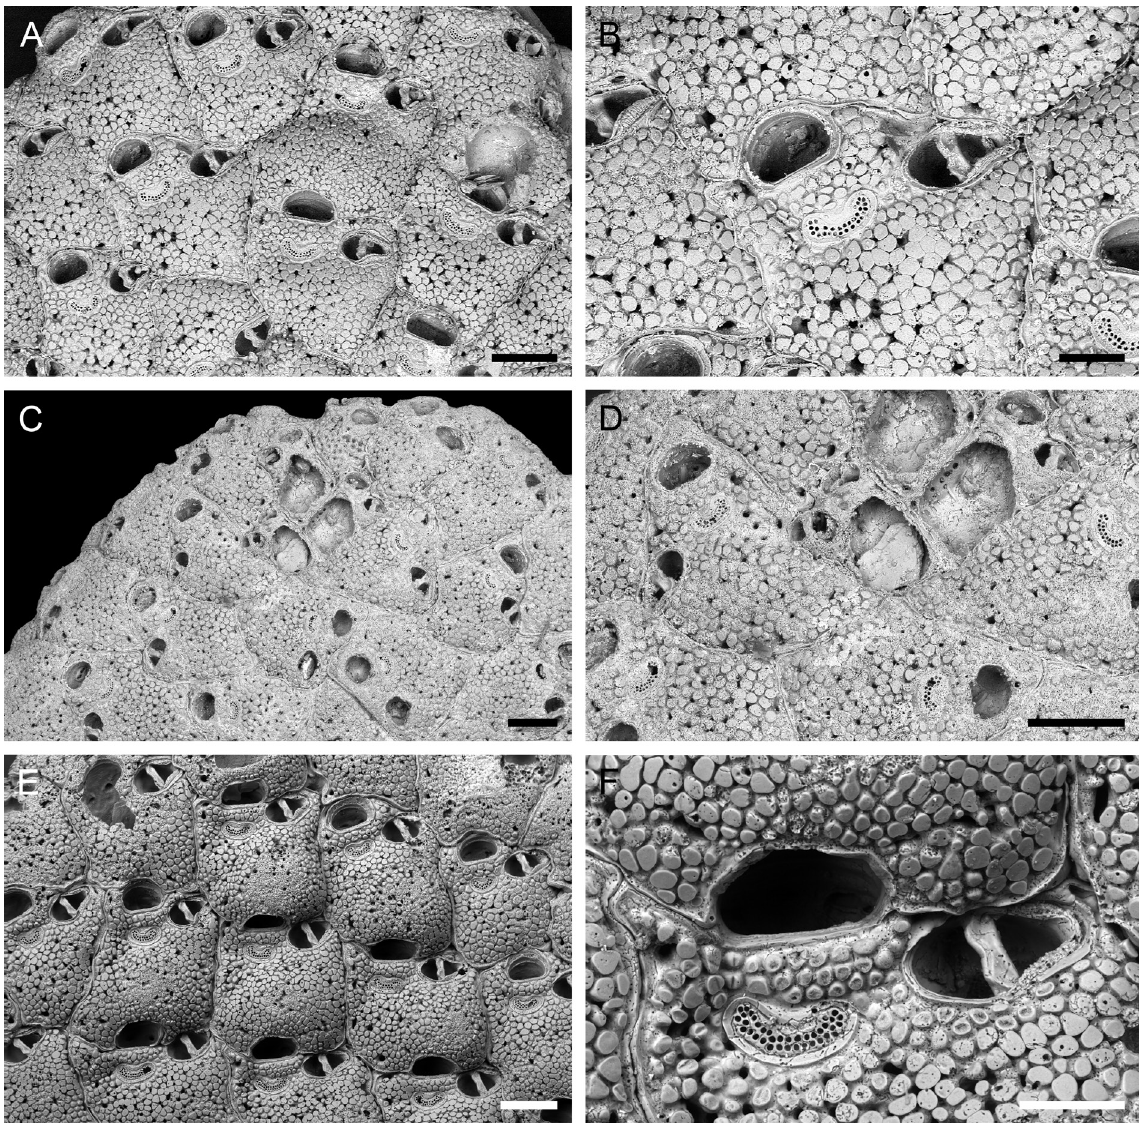
Fig. 10. Microporella lingulata sp. nov., paratypes, Recent, Foveaux strait, New Zealand. A–B . NIWA 144887. A . Group of ovicellate and non-ovicellate zooids. B . Close-up of an autozooid showing the reniform, cribrate ascopore. C–D . NIWA 144888. C . General view of the branch proximal tip